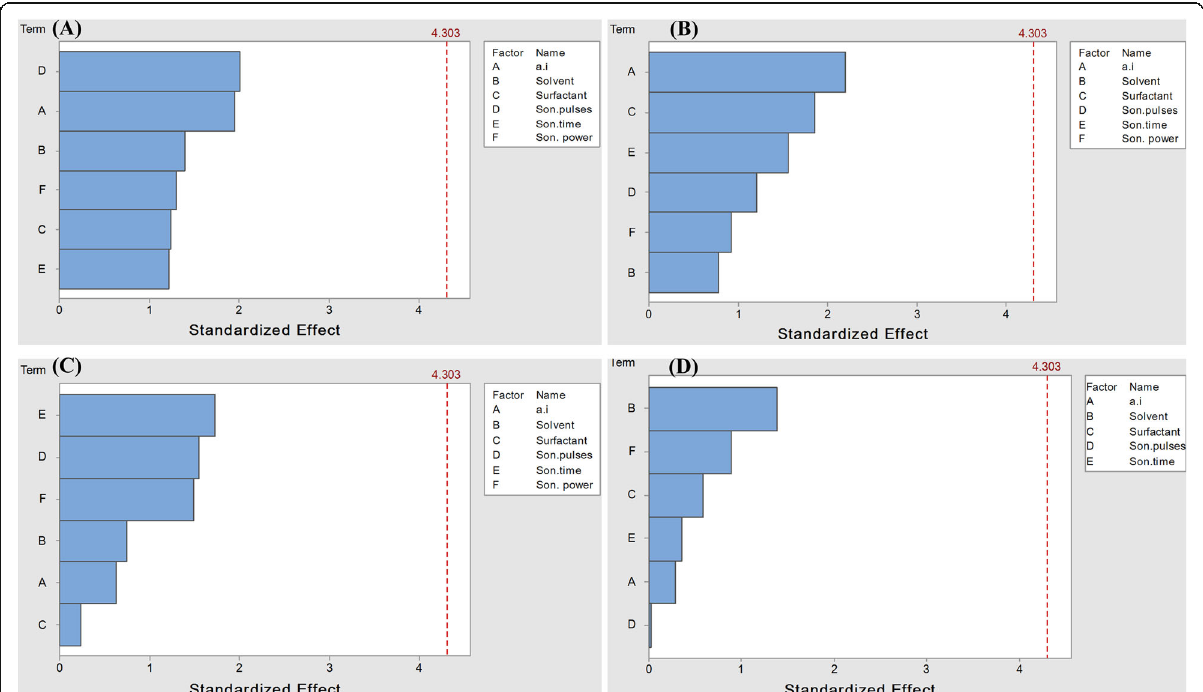
Fig. 2 Pareto charts representing the effect of factors and process variables on viscosity ( A ), droplet size ( B ), PDI ( C ), and pH ( D ) for deltamethrin nanoemulsions at α = 0.05